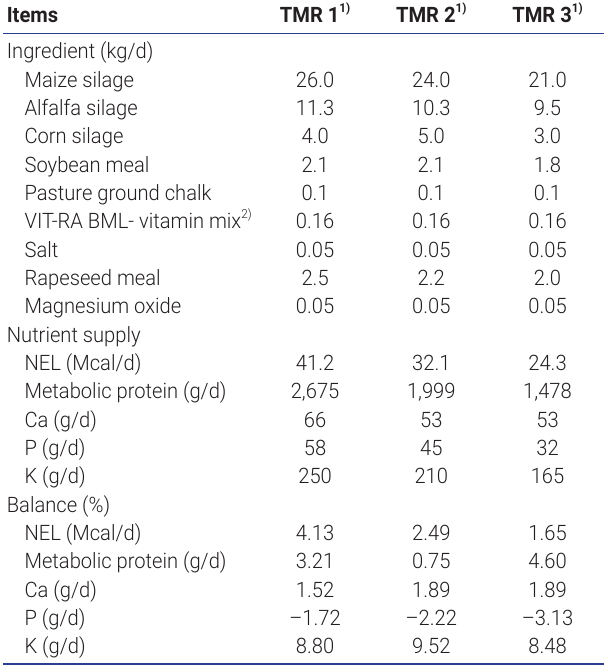
Table 1. The ingredient composition of total mixed ration and nutrient balance between cows in different stages of lactation Items TMR 1 1) TMR 2